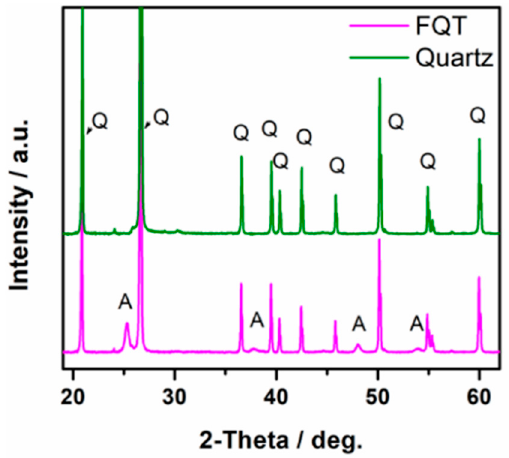
Figure 2. XRD patterns of bare quartz and TiO 2 –SiO 2 –Quartz composite (FQT), Q and A refer to quartz and anatase patterns, respectively.